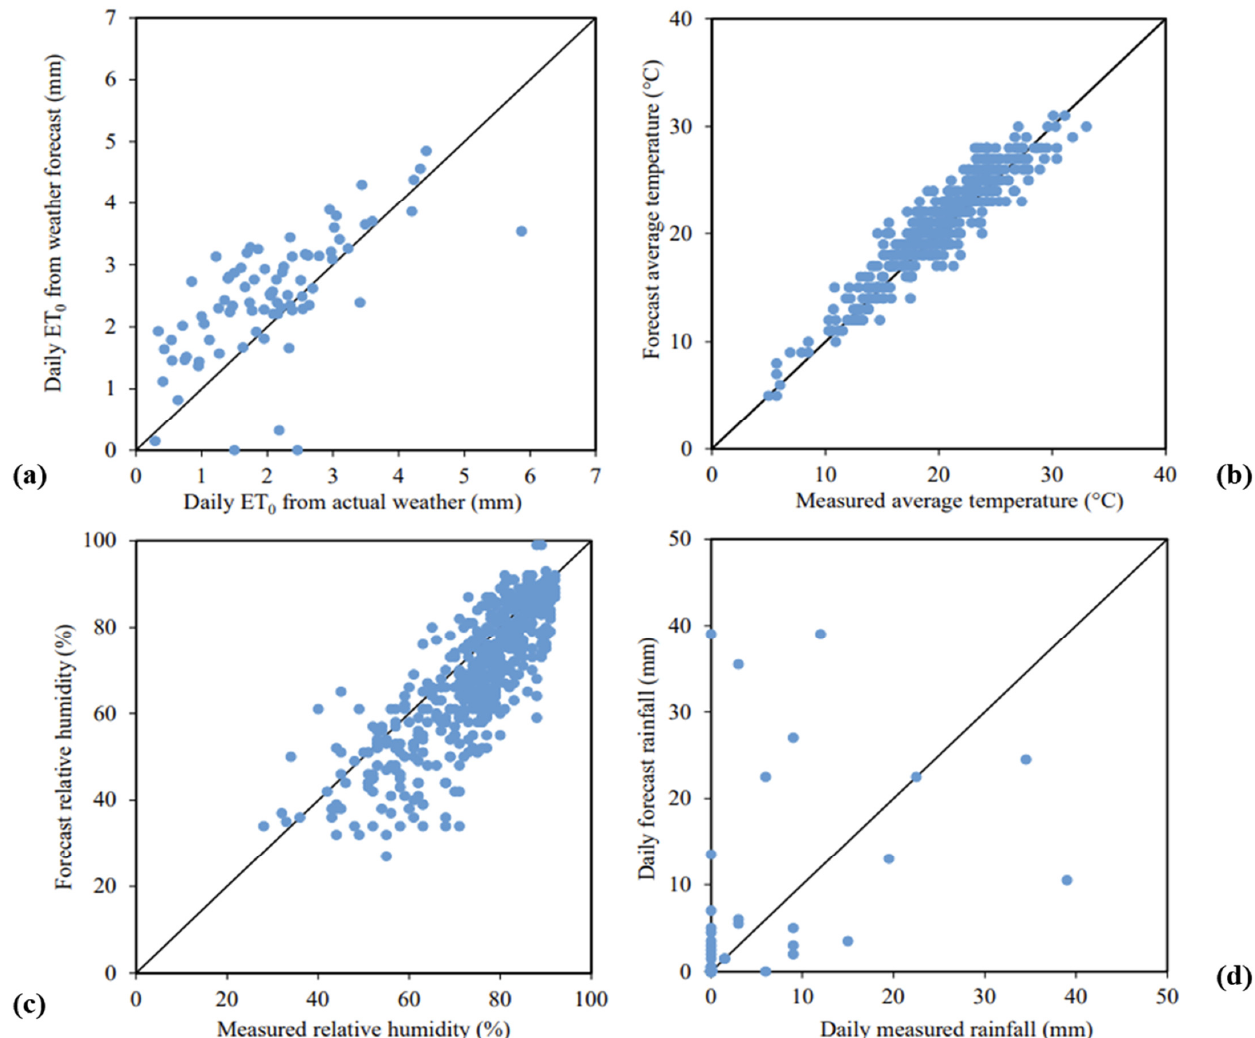
Figure 16. The comparison between weather station measured and forecast weather factors. ( a ) ref- erence evapotranspiration ( ET 0 ), mm; ( b ) hourly average temperature, °C; ( c ) hourly relative hu- midity, %; ( d ) daily rainfall, mm.